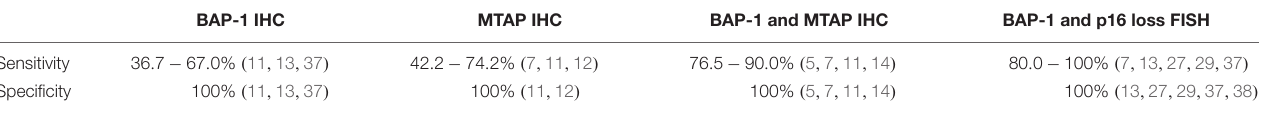
TABLE 4 | Sensitivity and specificity of individual and combined immunohistochemical markers and p16 loss by FISH. BAP-1